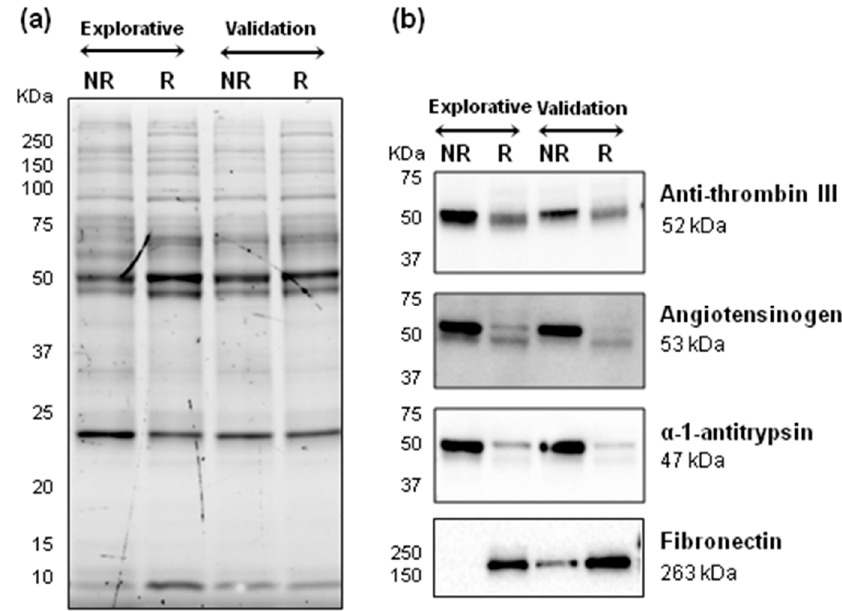
Figure 1. Immunoblotting validation of differential abundance of plasma proteins between non-relapsing (NR) and relapsing (R) HL (pools of three samples each). ( a ) Chemidoc image of gel before transfer of proteins to nitrocellulose membranes. ( b ) Blots probed with primary antibodies against four differentially abundant proteins.